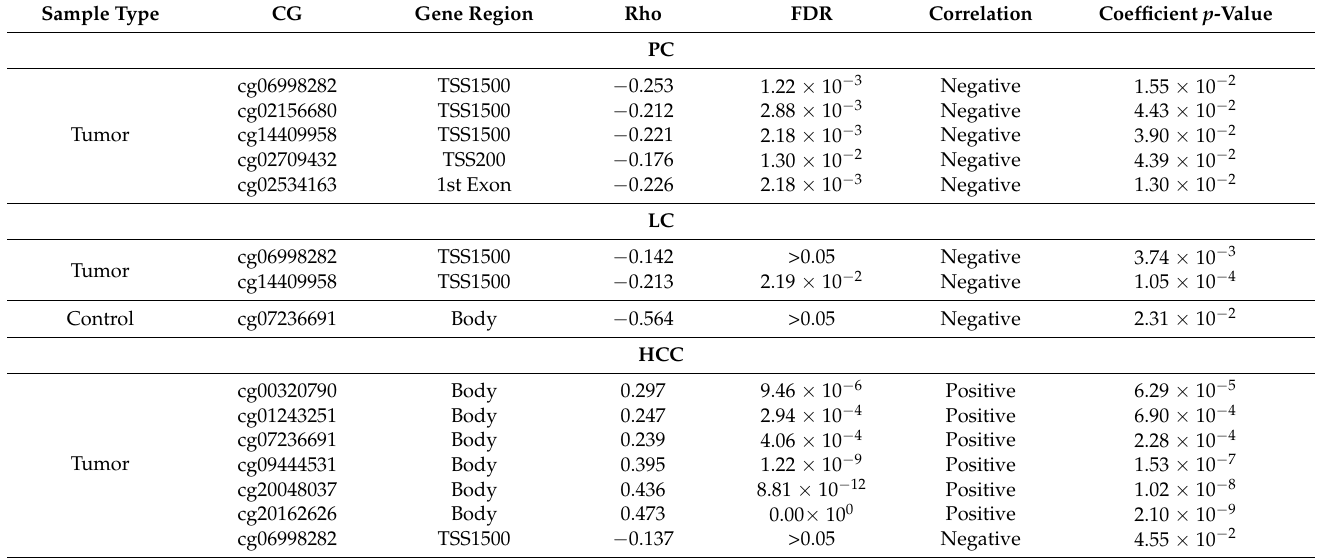
Table 6. Spearman correlation coefficient between ENPP2 CG methylation and mRNA expression ( p < 0.05) for PC, LC and HCC samples, showing mainly a negative correlation with PA CG methylation and in most cases a positive correlation with gene body